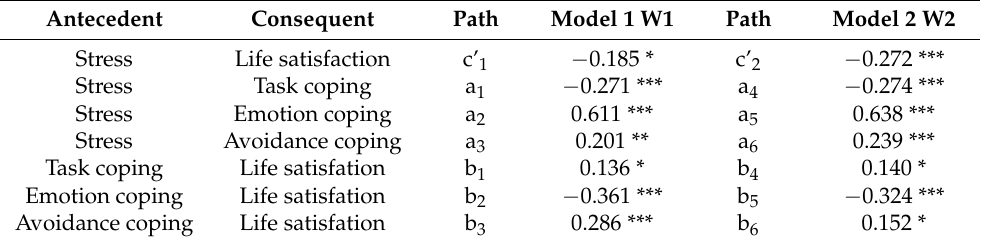
Table 5. Parameter estimates for latent structural mediation models in cross-sectional approach.